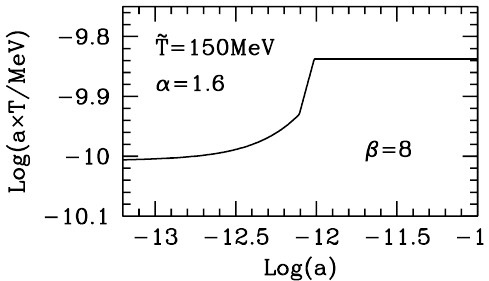
Figure 5. The product aT is plotted vs. a all through the transition. The angular points are an effect of the approximations used to model the transition and, in particular, of the assumption that quark carried B suddenly ceases to exist all through each